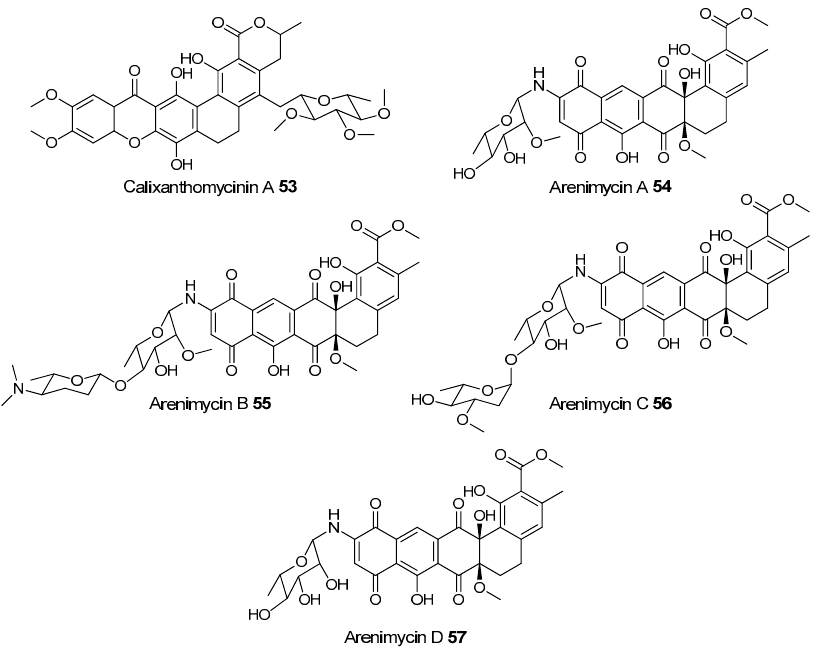
Figure 15. Pentangular polyphenols discovered from desert soil derived metagenomic libraries.